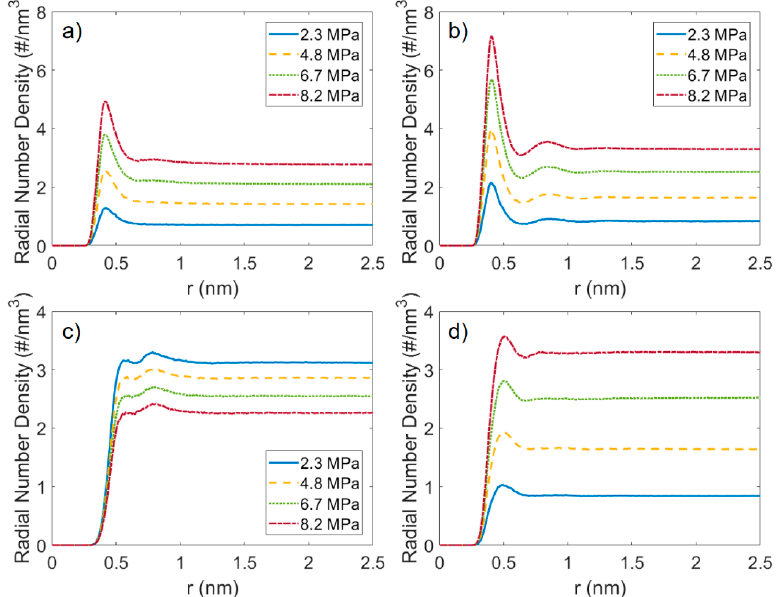
Figure 6. Radial number density of ( a ) CO 2 –CO 2 in the gas phase; ( b ) CO 2 –CO 2 in the liquid phase; ( c ) octane–octane in the liquid phase; ( d ) octane–CO 2 in the liquid phase. Note: octane–CO 2 (octane is the reference molecule, CO 2 is the surrounding molecule). # represents the number of molecules.